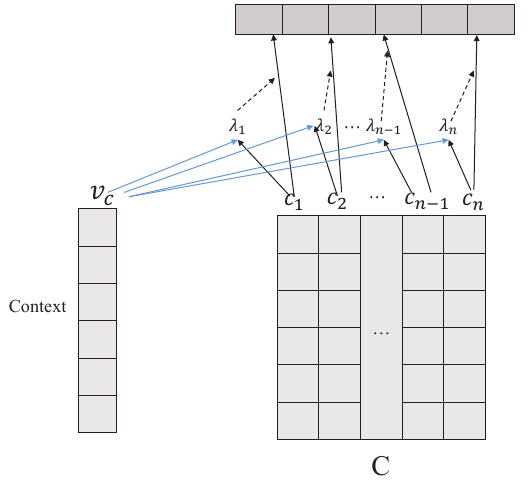
Figure 4. Interaction-Again Process in the Aggregated